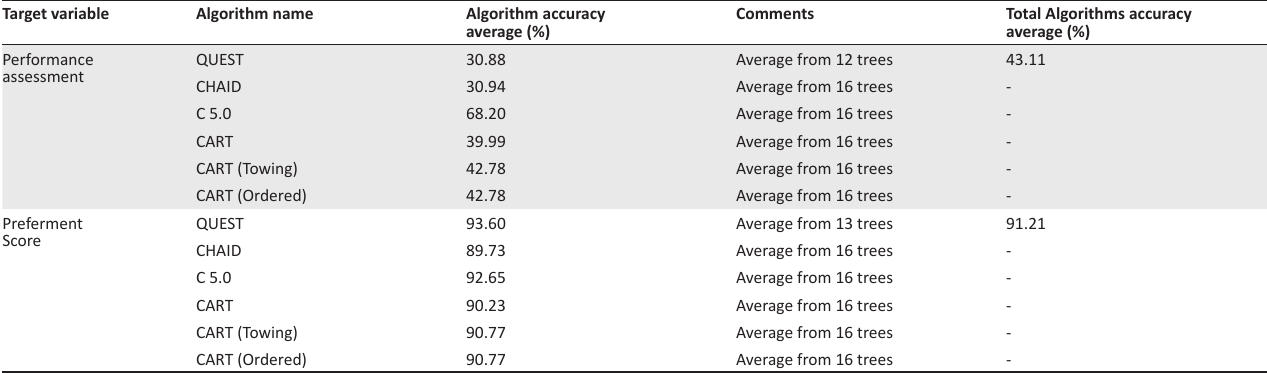
TABLE 4: Target variables accuracy from 185 perquisite trees. Target variable